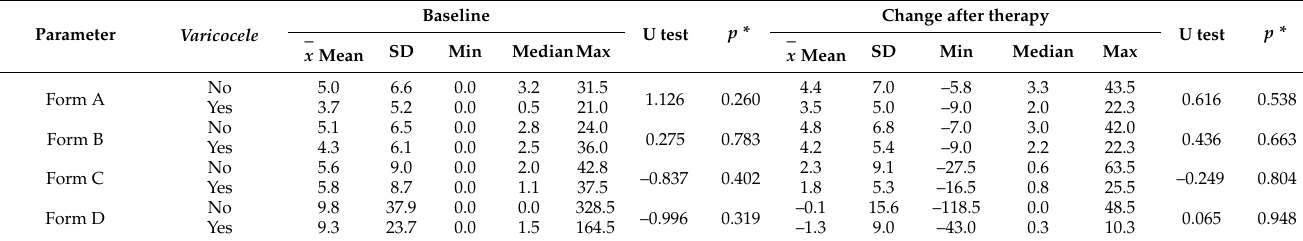
Table 8. Effects of treatment on total counts of sperm motility forms in the ejaculate in relation to the presence of varicocele